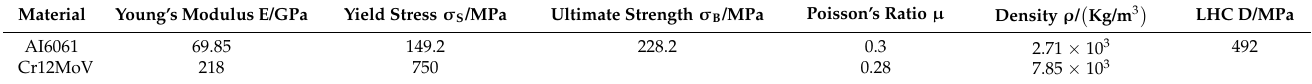
Table 1. Mechanical properties used in FEM.